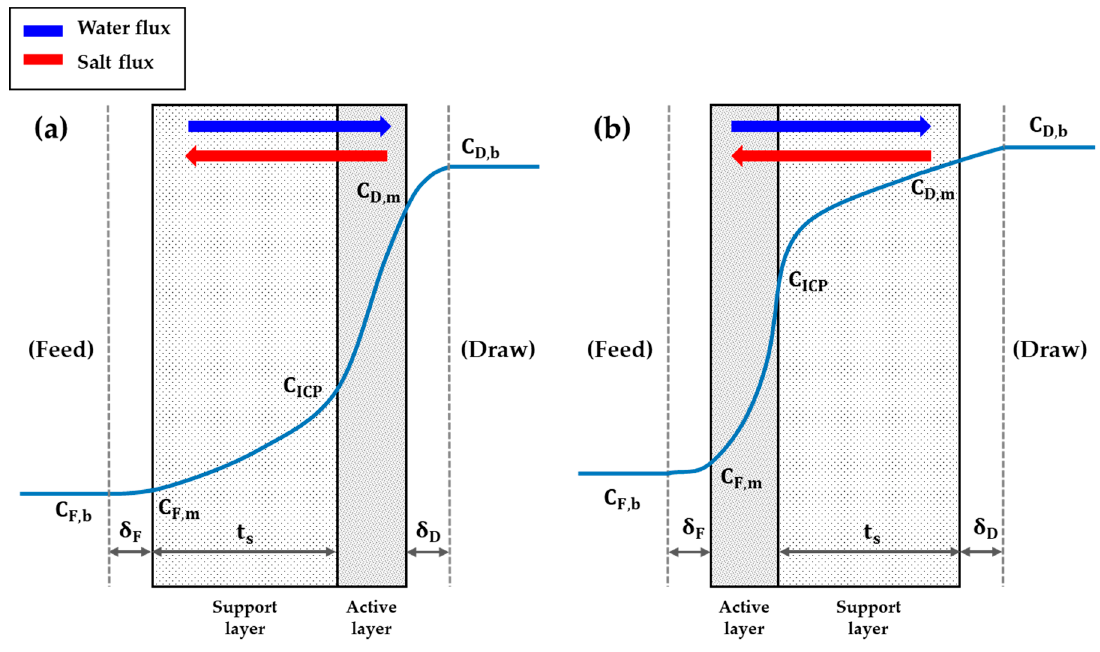
Figure 3. The structure of a PRO membrane of ( a ) which an active layer faces a draw solution side, and ( b ) of which a support layer faces a draw solution. and ( b ) of which a support layer faces a draw